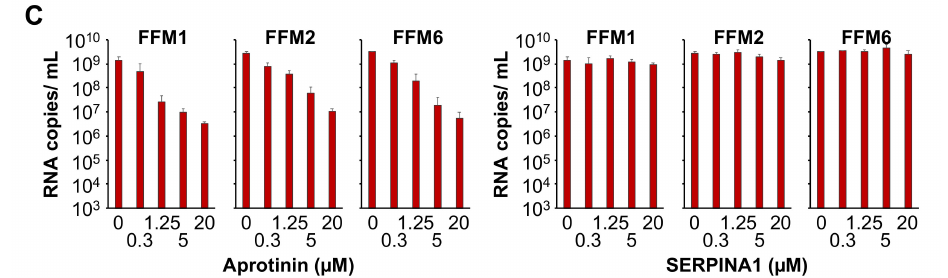
Figure 1. Anti-severe acute respiratory syndrome virus 2 (SARS-CoV-2) e ff ects of aprotinin and SERPINA1 / alpha-1antitrypsin.( A )Concentration-dependente ff ectsofaprotininandSERPINA1 / alpha-1 antitrypsin on SARS-CoV-2-induced cytopathogenic e ff ect (CPE) formation determined 48 h post-infection in Caco2 cells infected at a multiplicity of infection (MOI) of 0.01 with the three di ff erent SARS-CoV-2 isolates. The viability of the Caco2 cells was 84.3 ± 2.7% relative to the untreated control in the presence of 20 µ M of aprotinin. ( B ) Immunostaining for the SARS-CoV-2 S protein in aprotinin- and SERPINA1 / alpha-1 antitrypsin-treated Caco2 cells infected at an MOI of 0.01 with the three di ff erent SARS-CoV-2 isolates as determined 48 h post-infection. The protease inhibitors were tested at four concentrations in 1:4 dilution steps ranging from 20 to 0.3125 µ M. A quantification is provided in Figure S1. ( C ) Copy numbers of genomic RNA in Caco2 cells infected with di ff erent SARS-CoV-2 isolates (MOI of 0.01) in response to treatment with aprotinin or SERPINA1 / alpha-1 antitrypsin as determined 48 h post-infection. FFM1, 1 / Human / 2020 / Frankfurt; FFM2, 2 / Human / 2020 / Frankfurt; FFM6, 6 / Human / 2020 / Frankfurt. Table 1. Aprotinin concentrations that reduce SARS-CoV-2-induced cytopathogenic e ff ect (CPE) formation, SARS-CoV-2 spike (S) levels, and SARS-CoV-2-induced caspase 3 / 7 activation by 50% (IC 50 ) asdeterminedinCaco2cellsinfectedwithdi ff erentSARS-CoV-2isolates(MOIof0.01)48hpost-infection. IC 50 ( µ M)